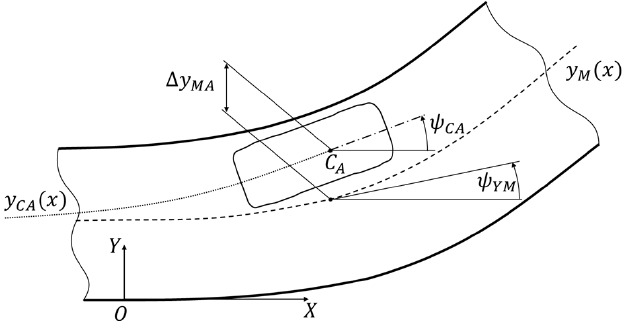
(cid:3014)(cid:3002) ) and the longitudinal axis of the car’s